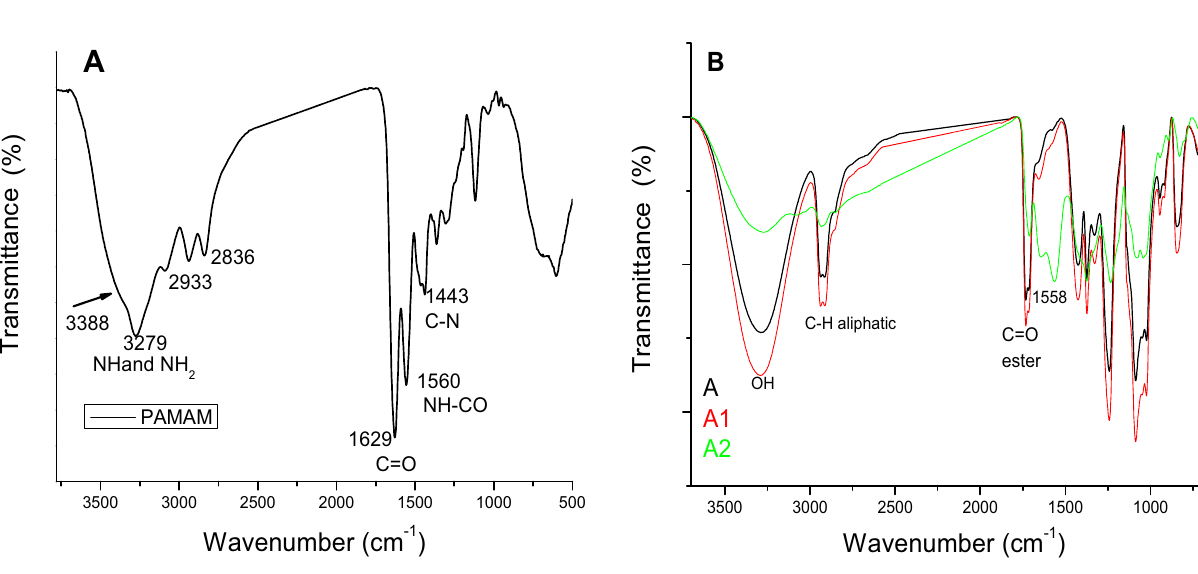
Figure 1. FTIR spectra of: ( A ) PAMAM and ( B ) prepared